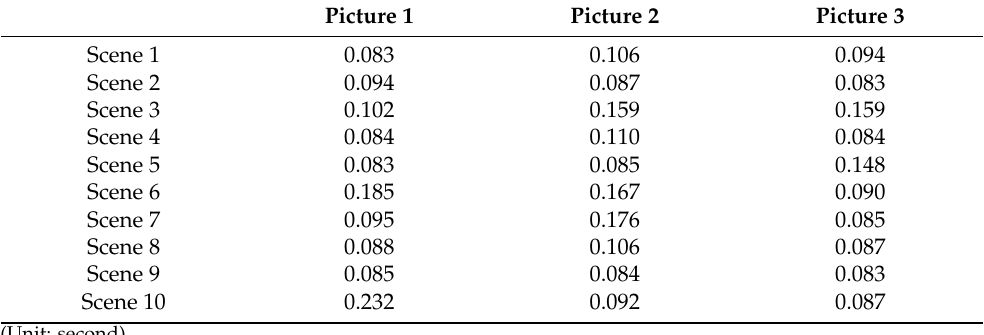
Table 3. Time to reconstruct the point cloud image.